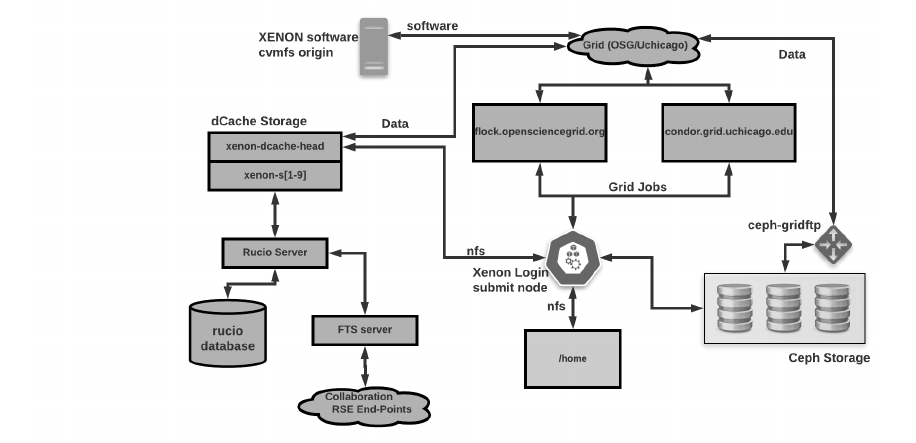
Figure 2. OSG infastructure at UChicago which supports the XENON experiment. The deployment has two components. The first component is the hosting of the Rucio / FTS server, Rucio DB and the XENON data for the UC_OSG_USERDISK Rucio Storage Element (RSE) on dCache storage. The second component is the submission host - login node - for job submissions to the OSG. In addition to this infrastructure, UChicago provides access to the HPC resource - Midway - for analysis and storage -